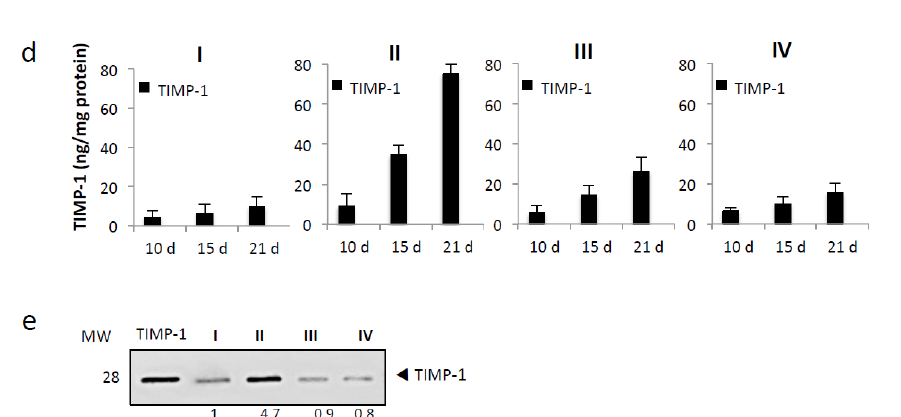
Figure 5. Tspan8-mediated melanoma cell invasion coincides with MMP-3 activation concomitantly with low TIMP-1. ( a , b ) The protein levels of total MMP-3 released in the supernatants from each culture model (I, II, II, IV described in Figure 4) were assessed at day 10, 15 and 21 by ELISA ( a ) and western blot ( b ), uncropped western blots figures in Figure S1. ( c ) Immunoblot analysis of MMP-3 in serum-free media harvested from SR integrating non-metastatic NM#1 melanoma cells ectopically expressing Tspan8 (TSPAN8 vector) and their control (control vector) or metastatic M#1 melanoma cells silenced (shTSPAN8) or not (shcontrol) for Tspan8. Equal amounts of total protein were loaded. The intensity value ratio of fully active MMP-3 / proMMP-3 was annoted beneath the blot ( d , e ). Serum-free media from the 4 culture models collected at day 10, 15 and 21 were analyzed for TIMP-1 content by ELISA ( d ) and western blot ( e ). ELISA results are represented as the mean ± SEM from three independent experiments, each measured in